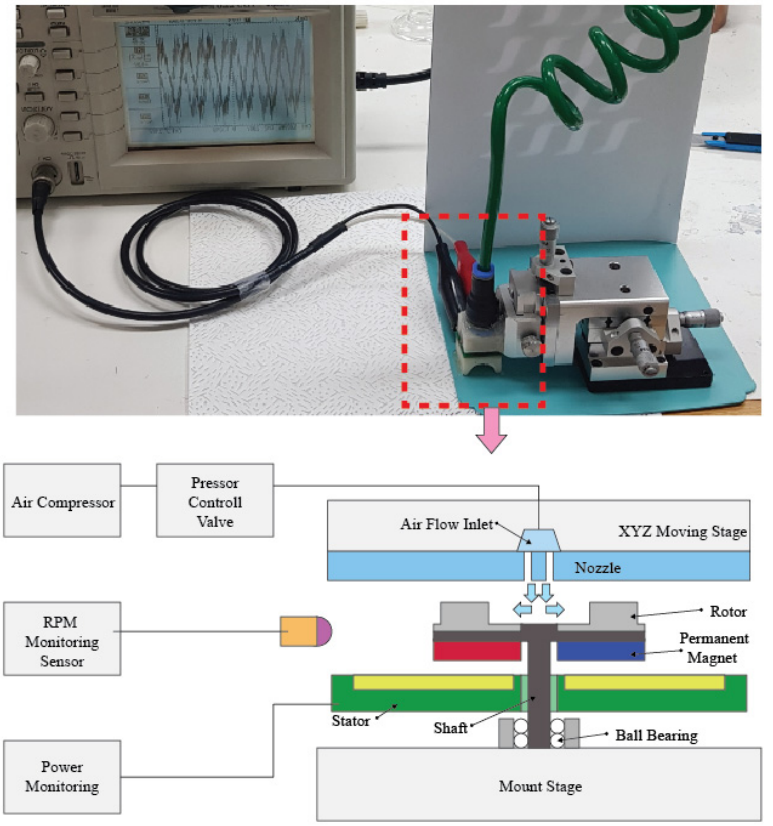
Figure 6. Measurement system for rotation and power-generating performance.